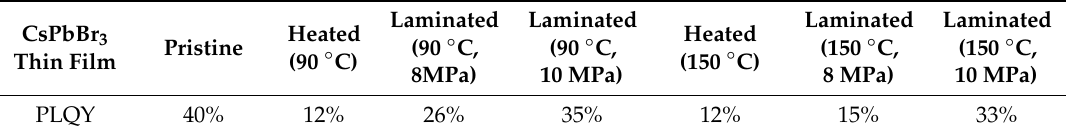
Table 1. Summary of photoluminescence quantum yield (PLQY) values of pristine CsPbBr 3 film and the laminates prepared under di ff erent conditions.